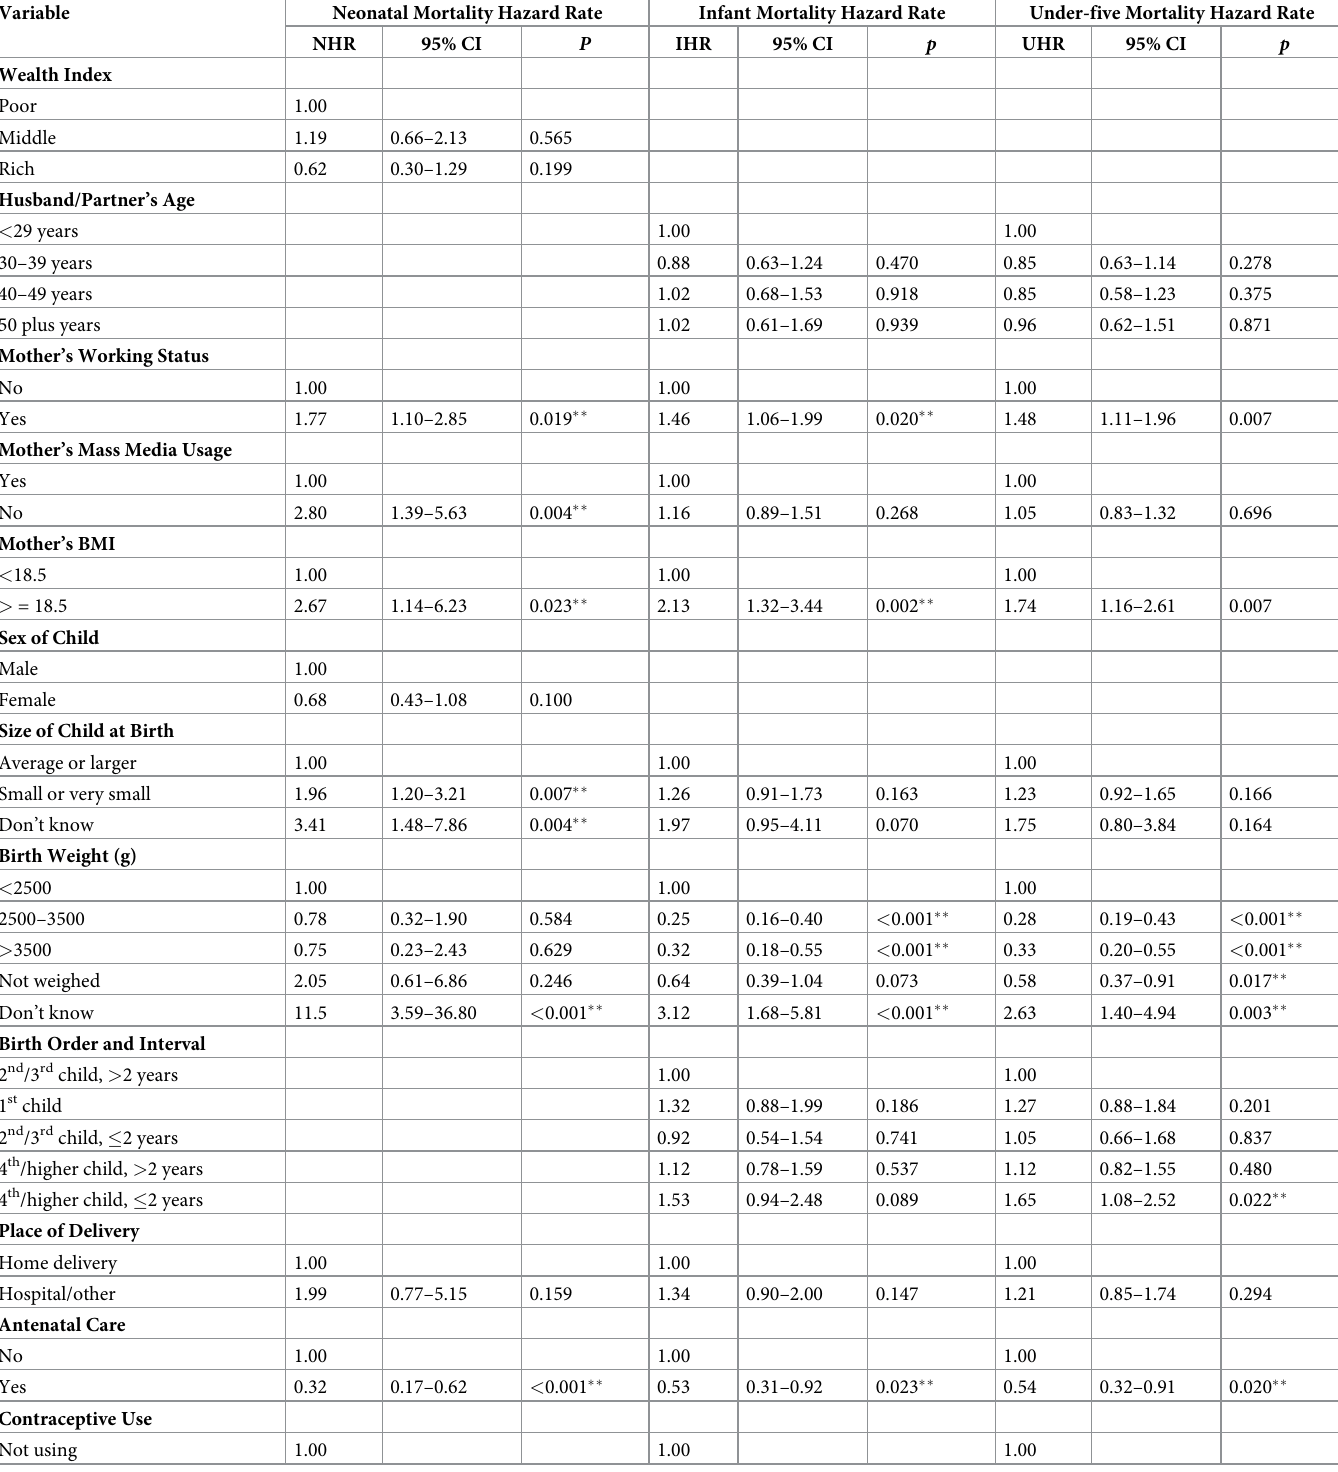
Table 6. Multivariate analysis of the association between neonatal, infant, and under-five mortality in East Africa and sociodemographic and behavioral